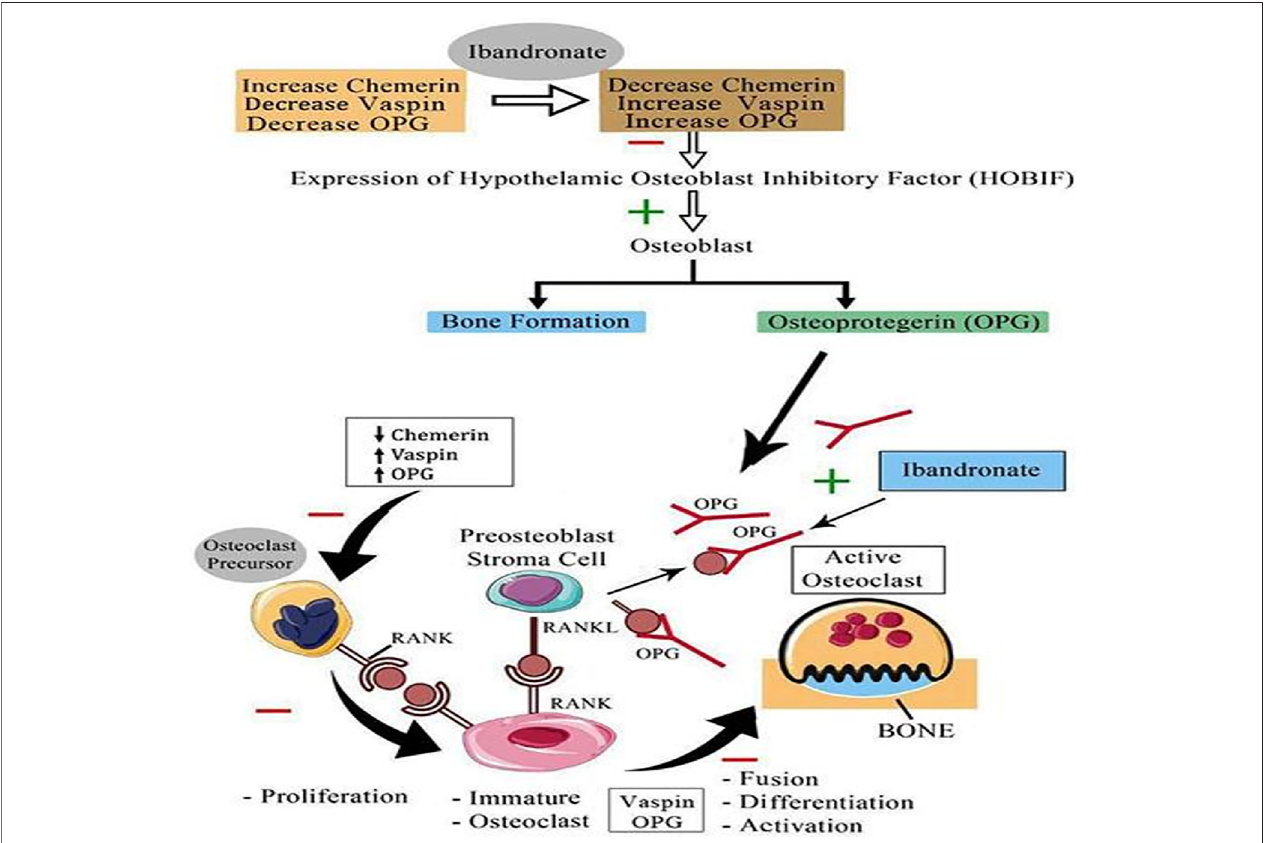
FIGURE 4 | Proposed mechanism of action of bisphosphonate (Ibandronate) on serum chemerin, vaspin and OPG; HOBIF, hypothalamic osteoblast inhibitory factor;OPG,osteoprotegerin;RANK,receptoractivatorofnuclearfactorkappa-Bligand;RANKL,receptoractivatorofnuclearfactorkappa-Bligandorosteoprotegerin ligand; inhibit; − , stimulate ＋ ; ↑ , increase; ↓